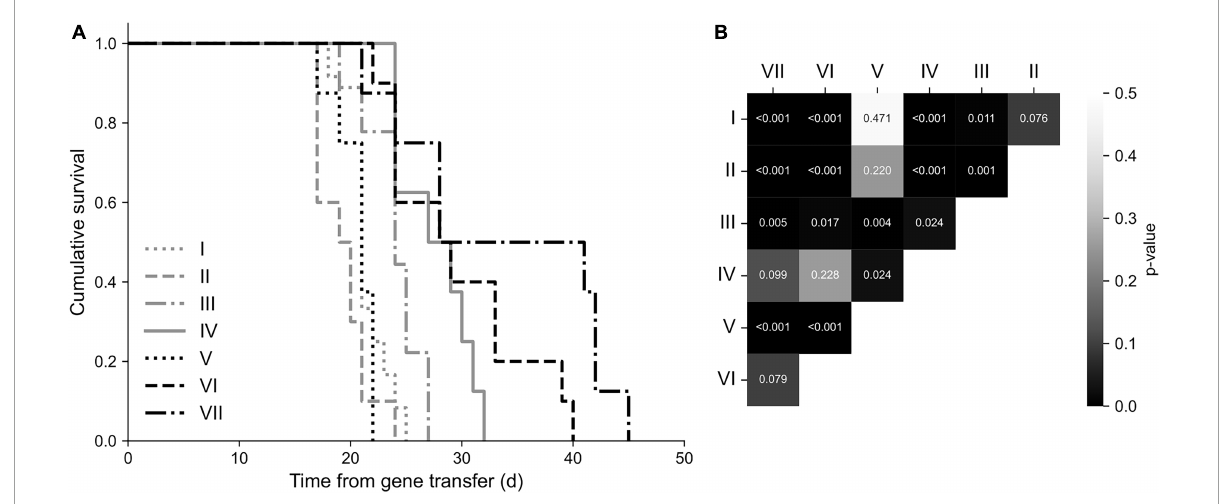
FIGURE5 Survival analysis. (A) Kaplan-Meier survival plot. The longest overall survival was observed in the group VII. (B) Statistically significant differences between the groups presented on a correlogram. Animals in the group VII had significantly prolonged survival time ( p < 0.001) compared to the groups I, II, V, and III ( p =